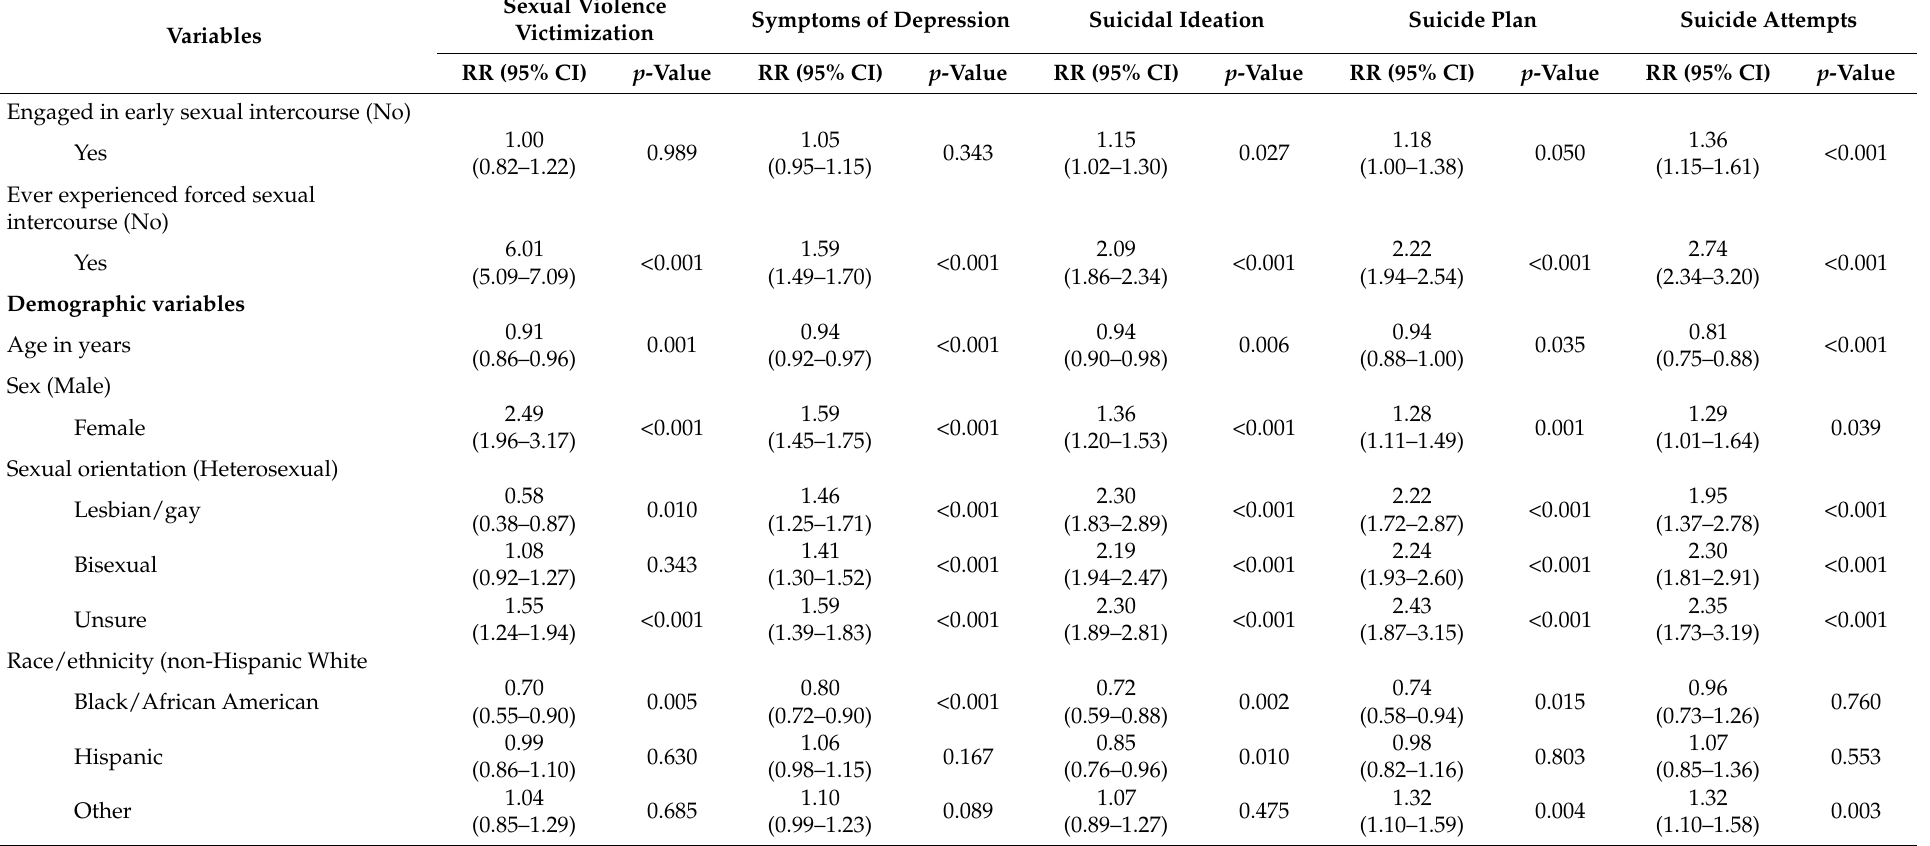
Table 3. Association between ESI and past 12 months SV victimization, symptoms of depression, and suicidal ideation among adolescents aged 14–18 who had ever had sex ( n = 6252).